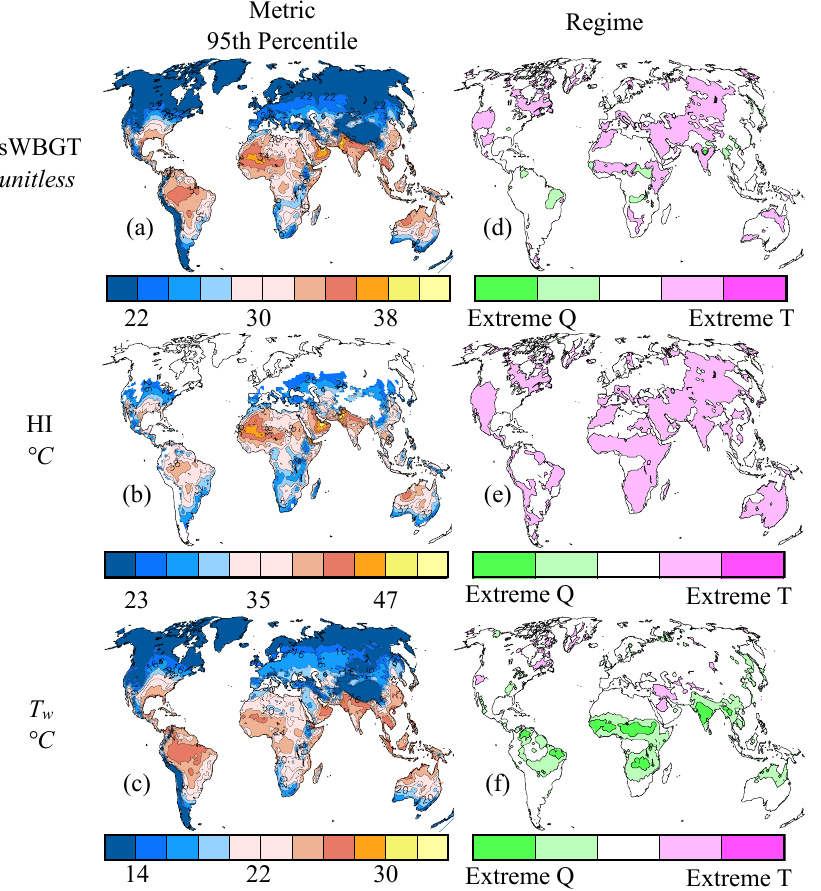
Figure 4. 95th percentile exceedance value of three metrics for (a) sWBGT, (b) HI, and (c) T w (left). Expected rank value T − Q regime maps (d) , (e) , and (f) (right) conditioned by (a) , (b) and (c) , respectively. Rank values for (d) – (f) are described in Fig.